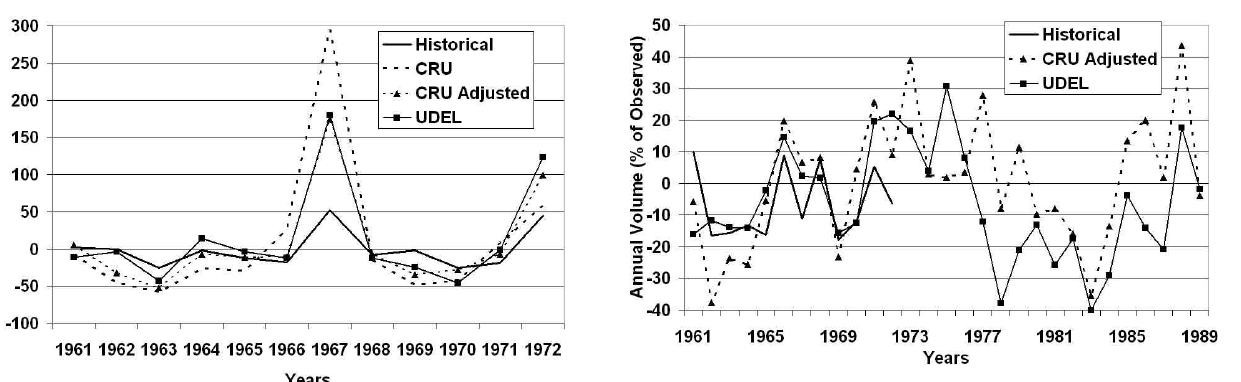
Fig. 5. Deviations (%) from observed of simulated mean annual flow volumes of the Okavango River at Rundu (using the main cal- ibration period of 1961 to 1972) based on different input rainfall data. “Historical” data are based on local gauges.